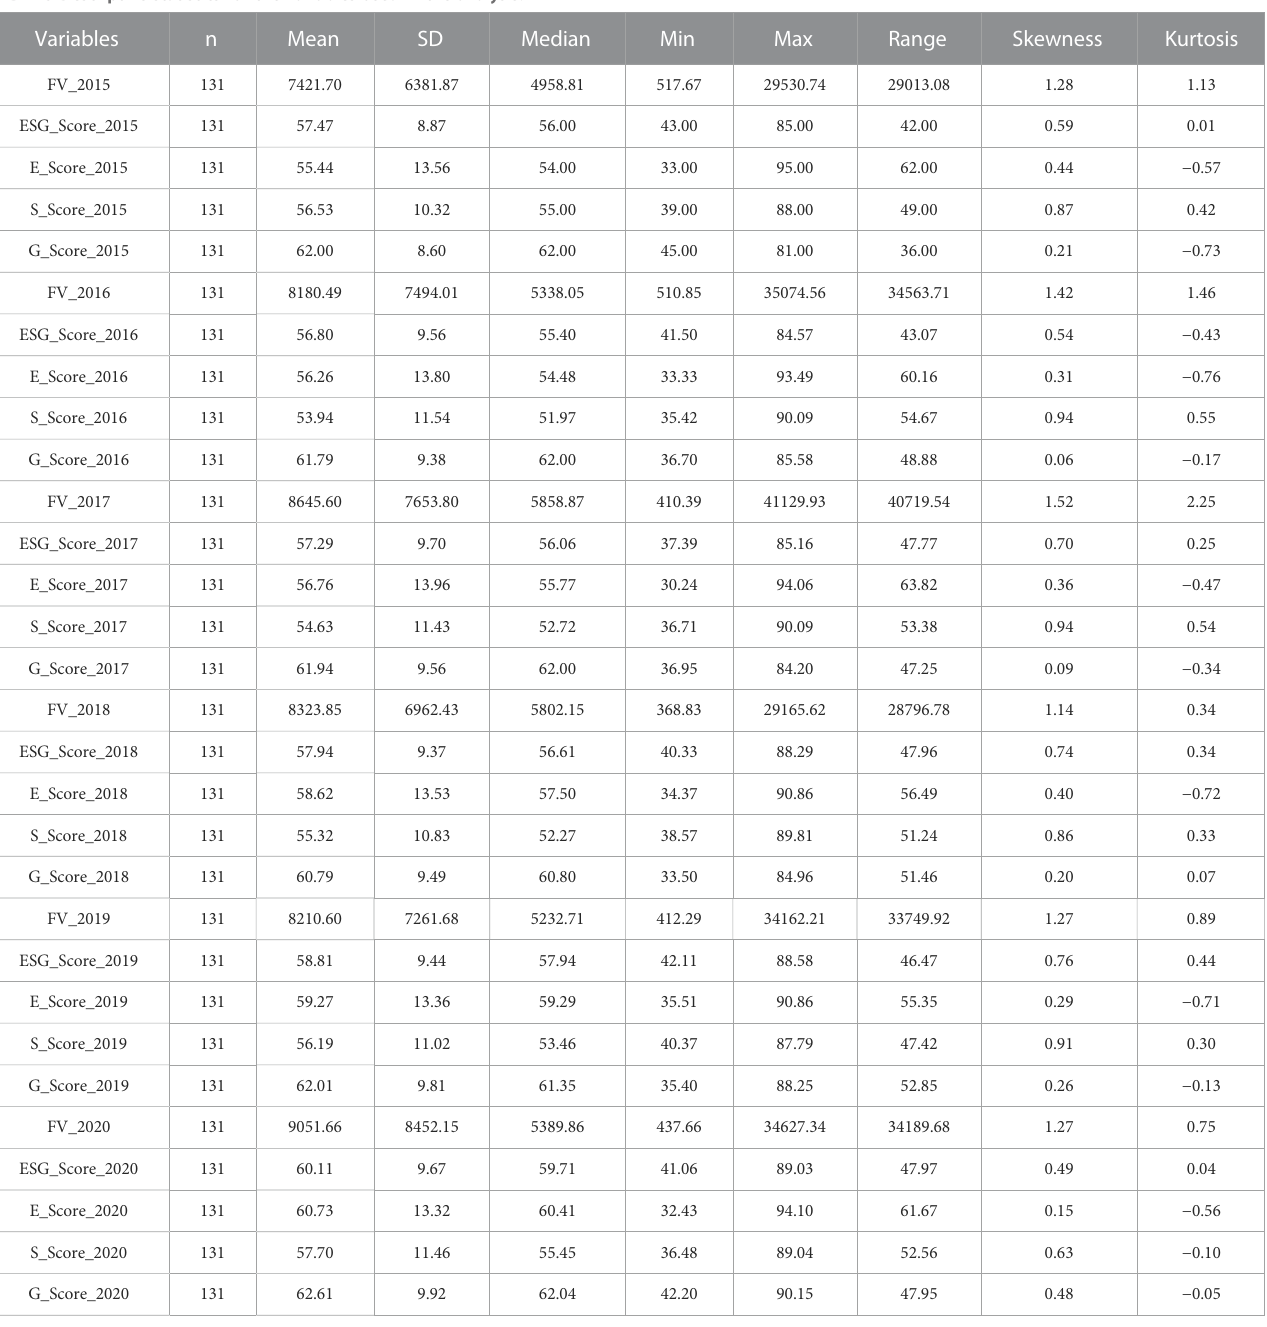
TABLE 3 Descriptive statistics for the variables used in the analysis. Variables